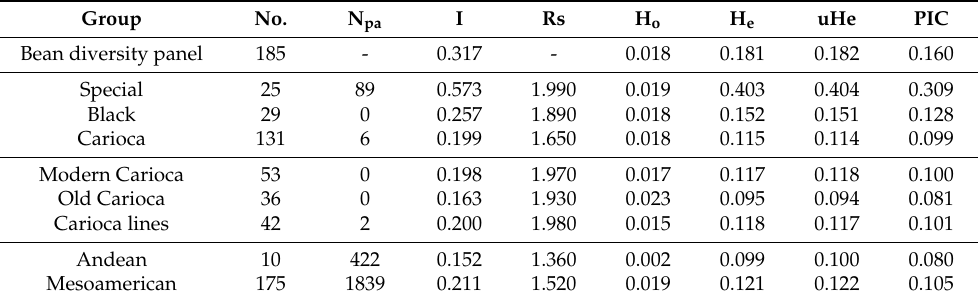
Table 1. Genetic diversity estimated for the Brazilian diversity panel using 2827 single nucleotide polymorphisms (SNPs), considering the genetic pools and the commercial class divisions.